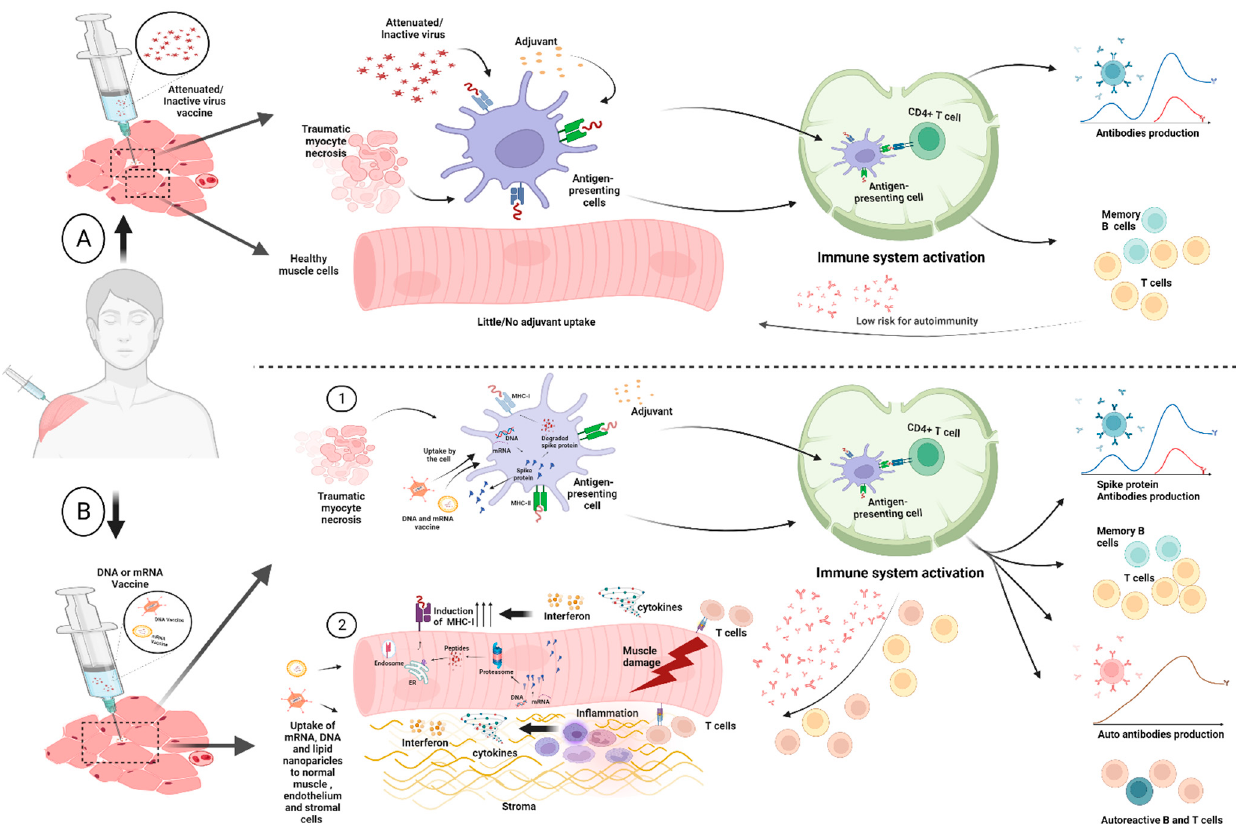
Figure 4. Panel ( A ): Conventional vaccines involve the delivery of a killed pathogen, attenuated pathogen or a protein subunit with adjuvants—including alum and others—to the inoculation site. This is associated with local muscle and endothelial and supporting tissue injury at the site of vaccination. It is thought that uptake of both the antigens and adjuvants by the antigen presenting cells leads to activation of such cells and migration to the regional lymph nodes where lymphocyte priming takes place and robust antibody responses to antigen takes place. In theory, vaccine-associated injury from the injecting needle might release self-antigens that are also taken up by the Antigen-Presenting Cells (APCs) and could theoretically lead to tolerance failure and autoimmunity. However, this is not something that is recognised in the clinical setting with conventional vaccines; hence, it seems unlikely to occur. Panel ( B ): Like Conventional vaccines, the novel DNA- and RNA-based vaccines are also taken up by antigen-presenting cells and migrate to regional lymph nodes and likewise damaged self-muscle, endothelial and stromal tissue elements from sites of injury could undergo pinocytosis and likewise be transported. Copying elements of the viral life cycle within APCs facilitates CD4 and cytotoxic CD8 T-cell responses, that are superior to conventional vaccines and could thus contribute also to the development of better cell-mediated immune responses [28,29].